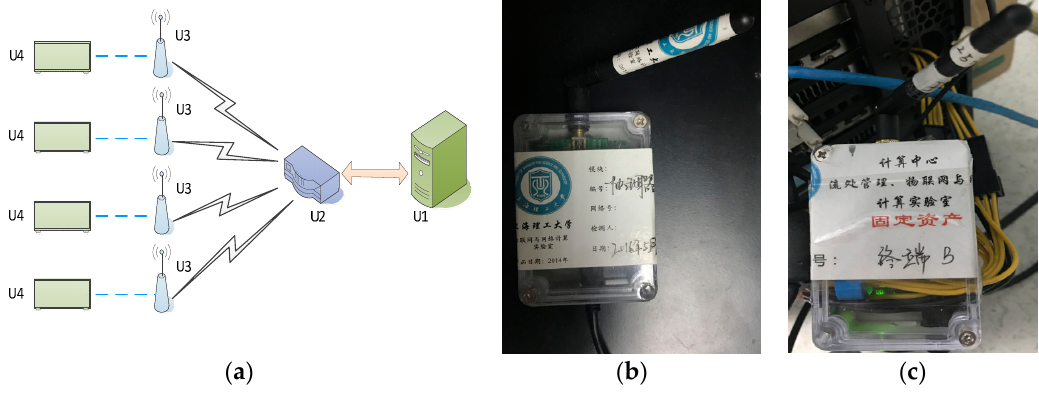
Figure 5. GPU energy consumption monitoring system: ( a ) The schematic diagram of the system; ( b ) The Zigbee coordinator; ( c ) A sensor node. (Note: The Chinese in caption indicates the affiliation and its identifier of this equipment.)